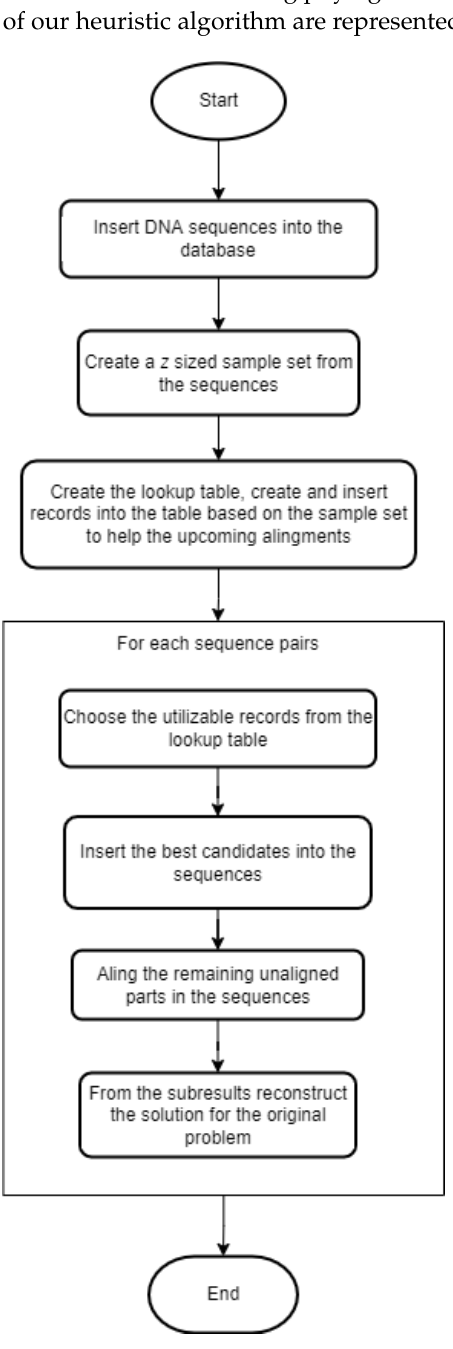
Figure 2. Flowchart of our heuristic algorithm